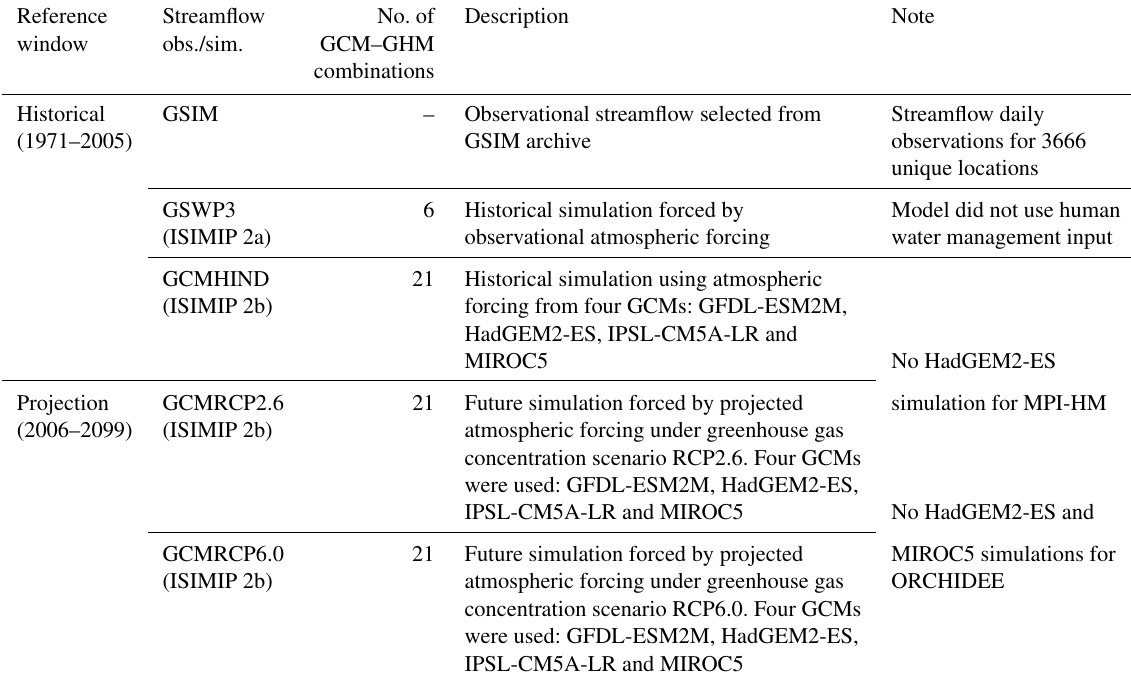
Table 1. Summary of streamflow observation and simulation datasets used in this study. GSIM was used as the observed streamflow database. Streamflow simulations were obtained from six GHMs (H08, LJPmL, MPI-HM, ORCHIDEE, PCR-GLOBWB and WaterGAP2). One ob- servational atmospheric forcing dataset (GSWP3) and outputs of four GCMs were used as input for streamflow